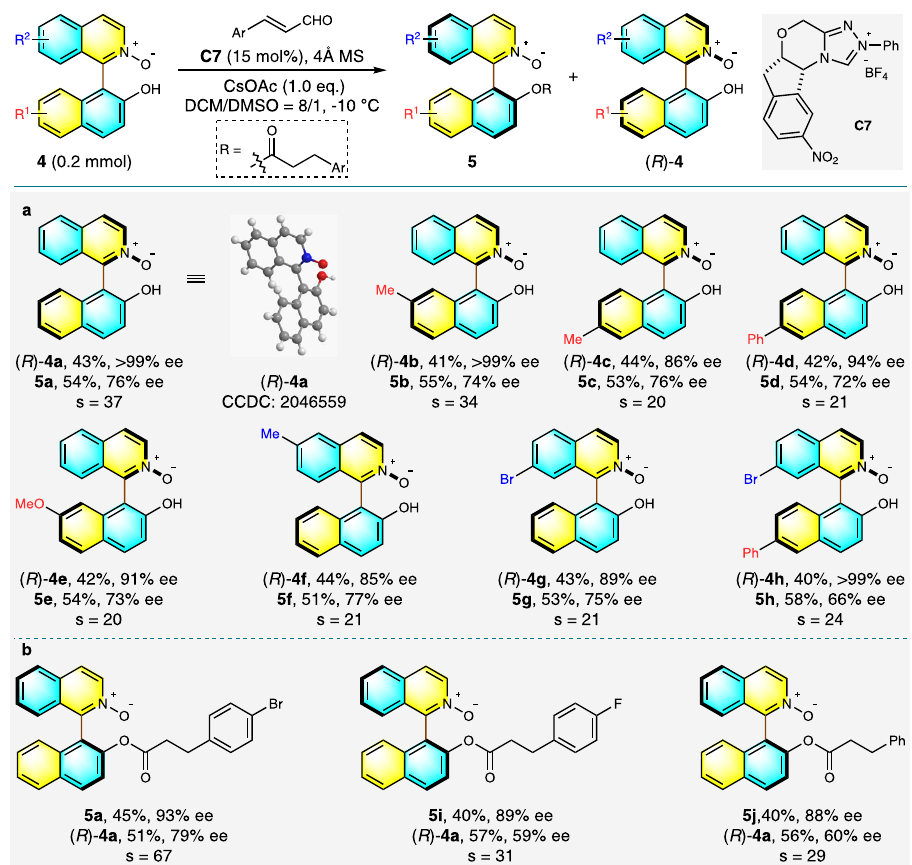
Fig. 5 Substrate scope of NHC-catalyzed kinetic resolution of QUINOL N-oxides. a Ar = 4-Br-Ph (0.65 eq. aldehyde). b with 0.5 eq. aldehydes.